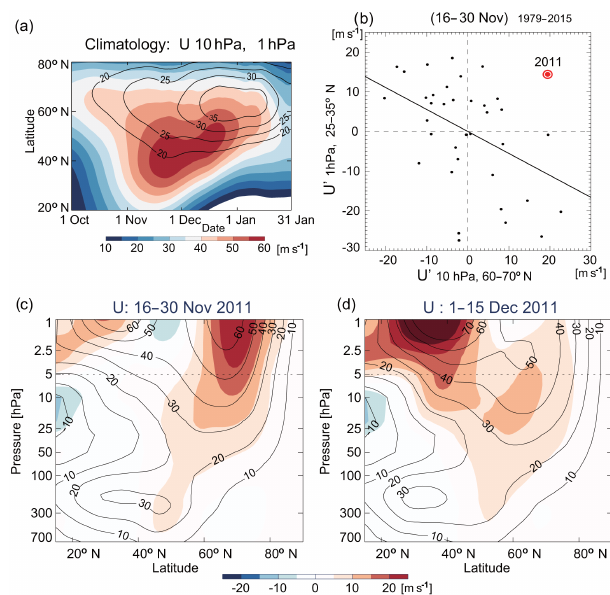
Figure 1. (a) Latitude–time section of the climatological zonal- mean zonal wind at 1hPa (colour shading) and 10hPa (contours). (b) Scatter diagram of the zonal-mean zonal wind averaged from 16 to 30 November over 25–35 ◦ N at 1hPa (ordinate) and 60–70 ◦ N at 10hPa (abscissa) for the period 1979–2015. The solid line in- dicates a regression line. (c) Height–latitude section of the zonal- mean zonal wind averaged from 16 to 30 November 2011. Contours and colour shading indicate the climatology and anomalies respec- tively. (d) Same as (c) but averaged from 1 to 15 December